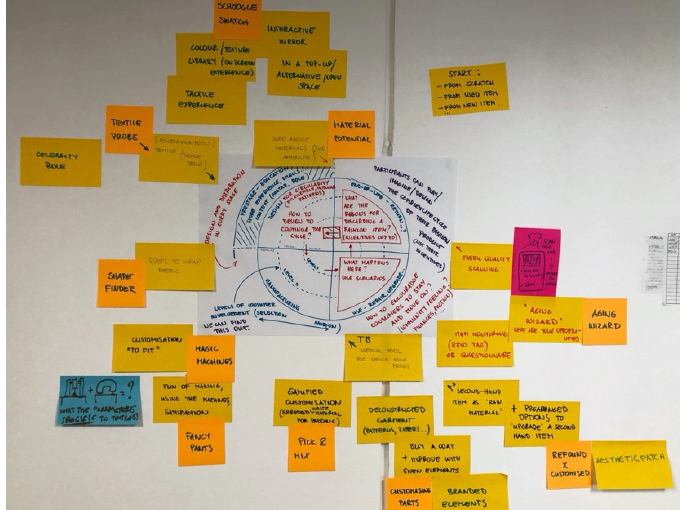
Figure 1. Mapping of ideated tools.